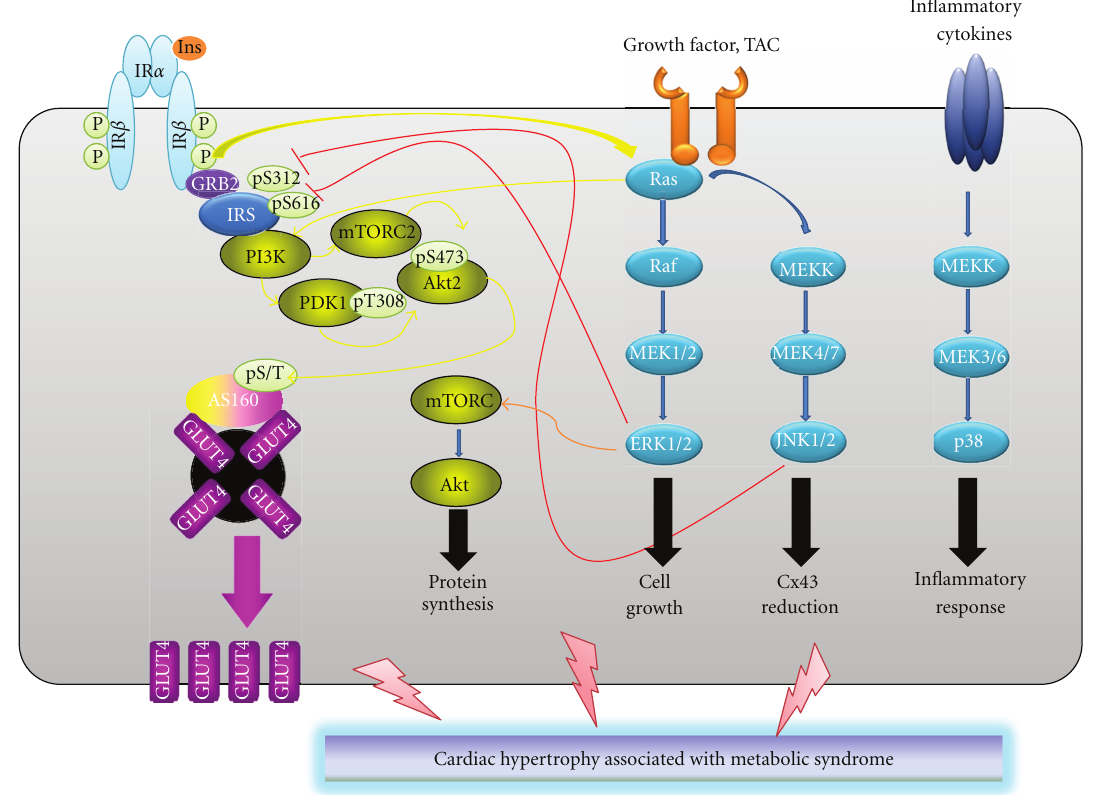
F 1: Intracellular pathways mediating hypertrophic cardiac remodelling in metabolic syndrome. Intracellular pathways mediated by phosphatidylinositol 3-kinase (PI3-K) activation play a pivotal role in insulin-mediated glucose transport in cardiomyocytes. Metabolic syndrome is associated with impaired intracellular signaling that could be activated by various stimuli, including in�ammatory cytokines. ese pathways, mainly dependent on MAPK activation (composed of extracellular signal-regulated kinase [ERK], c-Jun N-terminal kinase [JNK], and p38 MAPK), could be also triggered by chirurgical manipulation (such as transverse aortic constriction [TAC]). MAPK activation might be considered as a critical mechanism aggravating cardiac hypertrophy as well as cardiomyocyte insulin resistance in metabolic